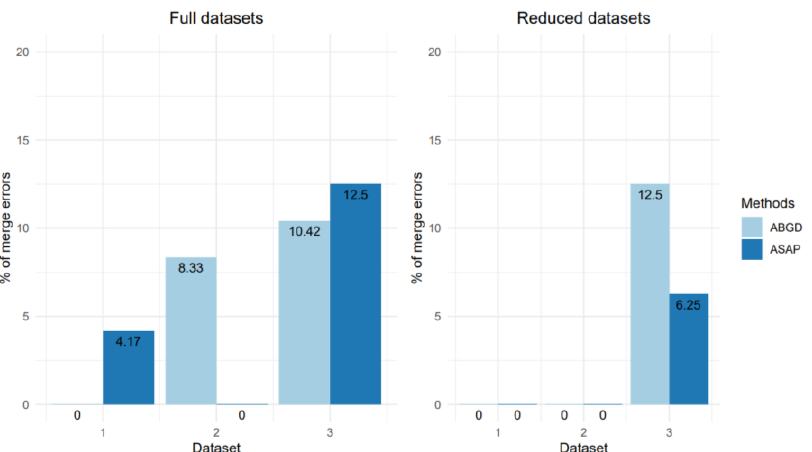
Figure 10. Mismatch rates corresponding to merges (when several putative species are grouped into a single OTU) obtained by processing dataset 1 with the ABGD and ASAP methods. The graphs represent, for the dataset in its full version or after reduced to one sequence per haplotype, the proportion of OTUs obtained that correspond to a grouping of several putative species.